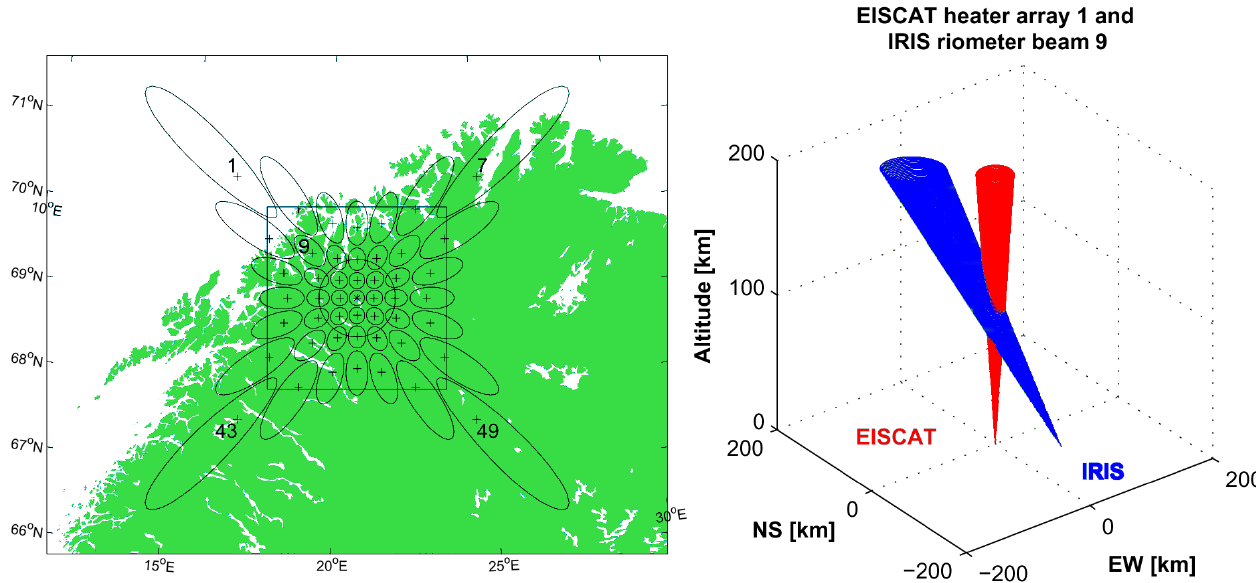
Fig. 1. Left panel: Kilpisjärvi IRIS riometer beam projections at 90km on a map of northern Scandinavia. Right panel: Intersection of the main lobe of EISCAT heater antenna field 1 and IRIS beam